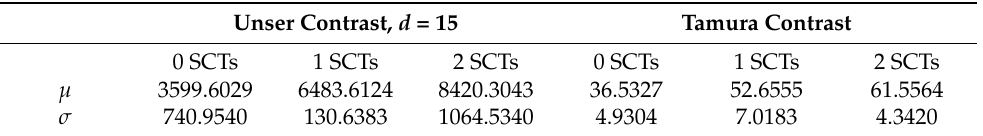
Figure 7. Data distributions of the contrast values for the VA signals with different SCT fault conditions: ( a ) Unser contrast and ( b ) Tamura contrast. Table 2. Mean ( μ ) and standard deviation ( σ ) for the different contrast distributions of the different SCT fault conditions.